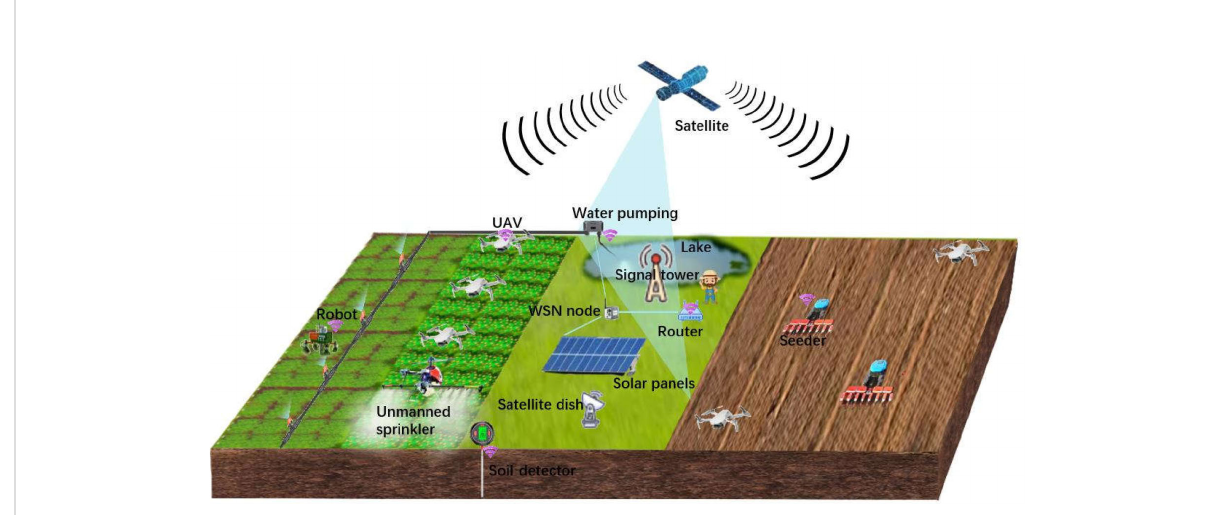
FIGURE 1 AI, sensors and robotics in plant phenotyping and precision